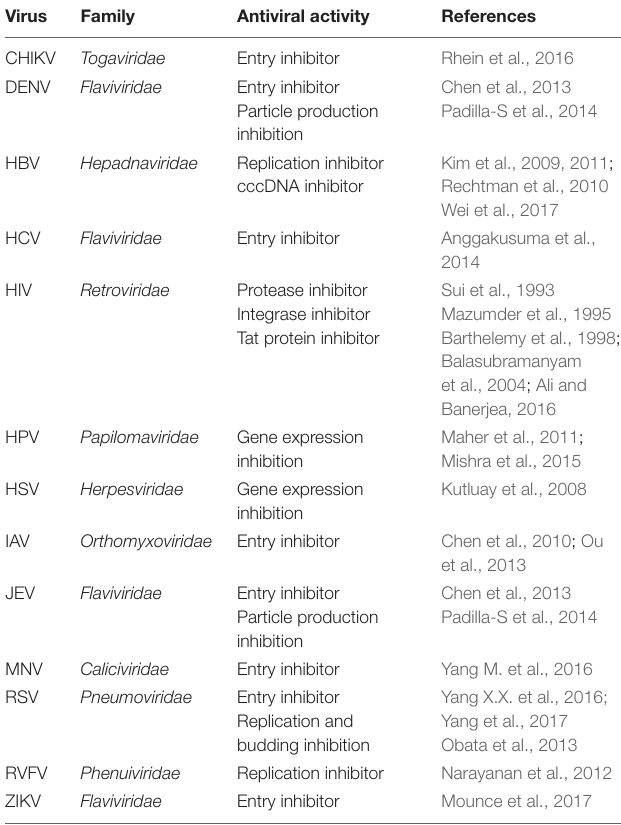
TABLE 1 | Antiviral activity of curcumin against several different